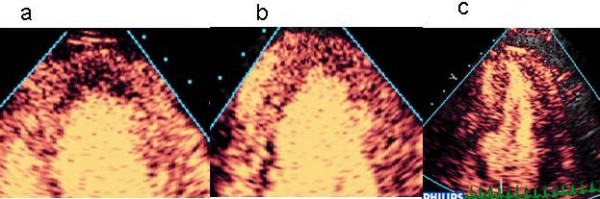
Contribution of regional shape changes to the identification of perfusion defects, including irregular wall contour in the apex (a) and mid-inferior segment (b), both associated with subendocardial defects. The C shape of the basal inferior segment complements the diagnosis of a perfusion defect in this segment. (c)